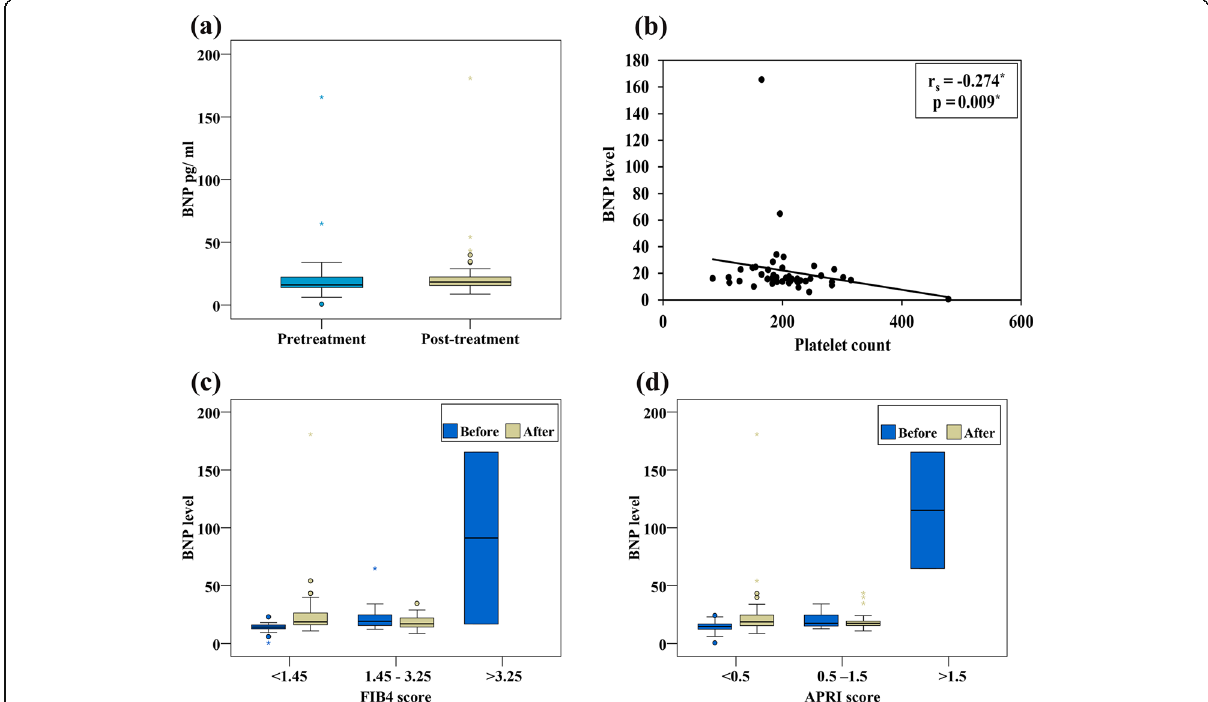
Fig. 1 a Comparison between plasma BNP levels pretreatment and post-treatment. b Correlation between plasma BNP levels and platelet count. c Relation between plasma BNP levels and pretreatment FIB4 score. d Relation between plasma BNP levels and pretreatment APRI score